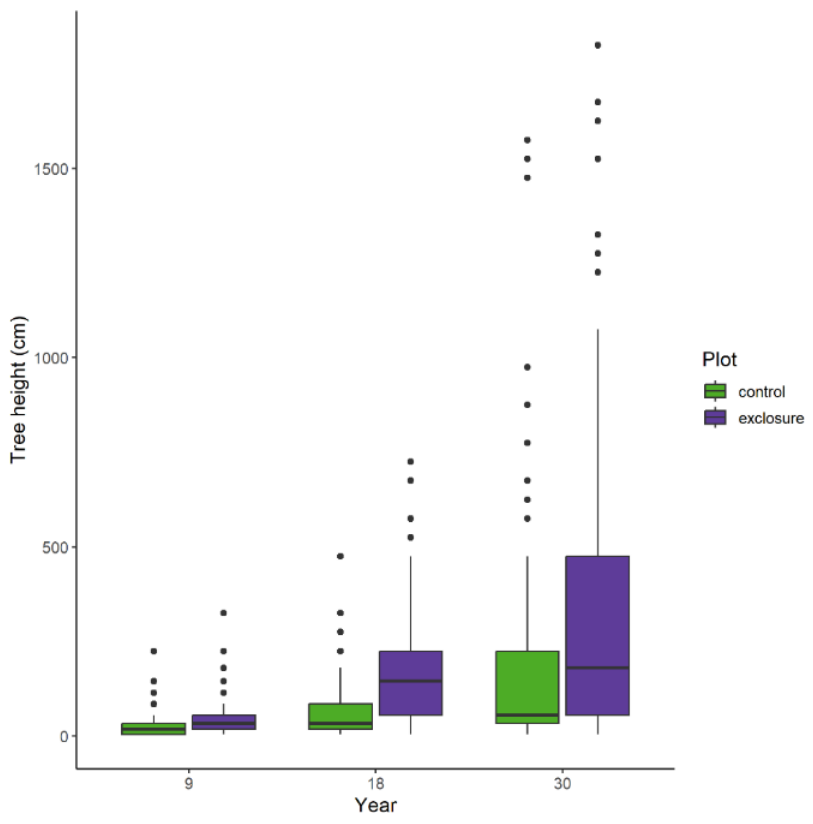
Figure 6. Boxplots of tree heights (cm) of the tallest individuals (n max = 6) per tree species recorded on control plots (green) and exclosure plots (purple) measured 9, 18, and 30 years after establishment of study plots. Table 8. Descriptive statistics (min, max, median) of height (cm) of the tallest individuals (n max = 6) per tree species detected on the 13 control and 13 exclosure plots throughout the 30-year study period and result of pairwise comparisons using Wilcoxon rank sum test with Bonferroni correction. Significance level of adjusted Wilcoxon rank sum tests p < 0.05.